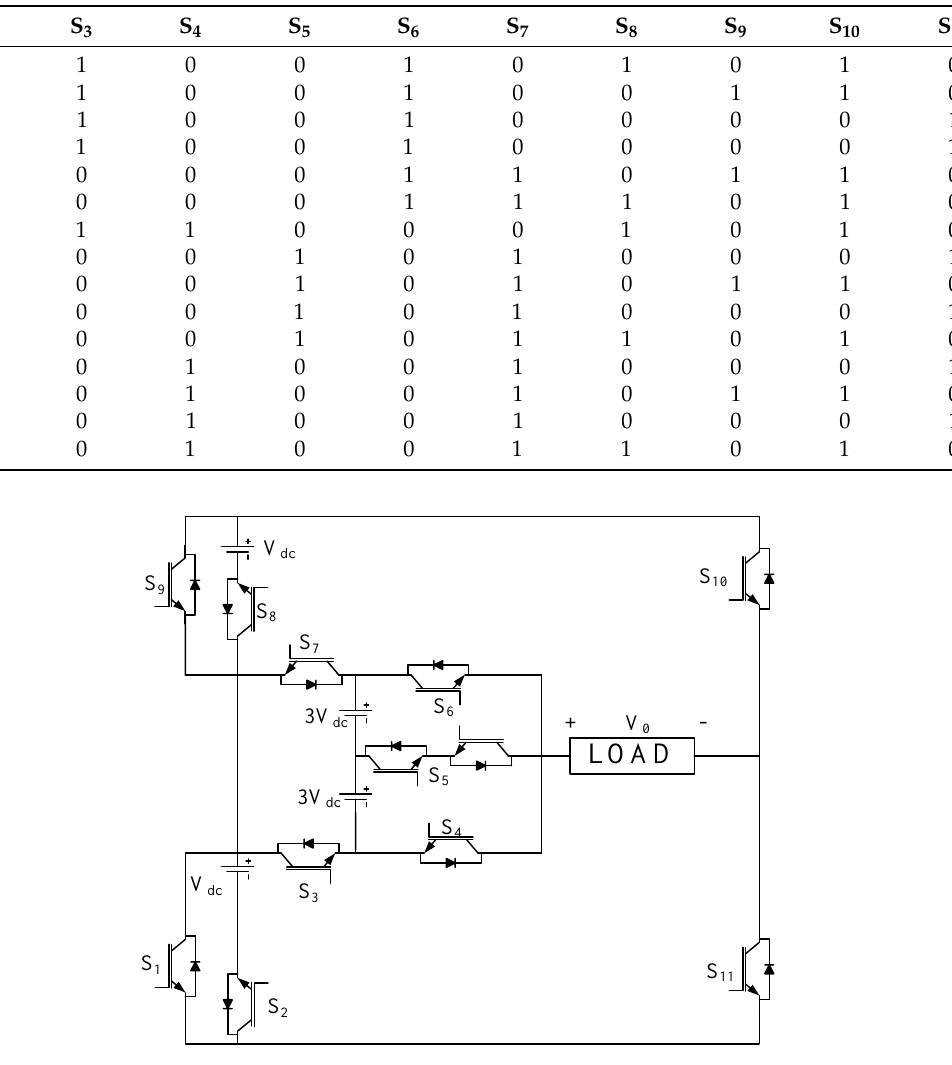
Figure 1. Structure of multilevel inverter topology.